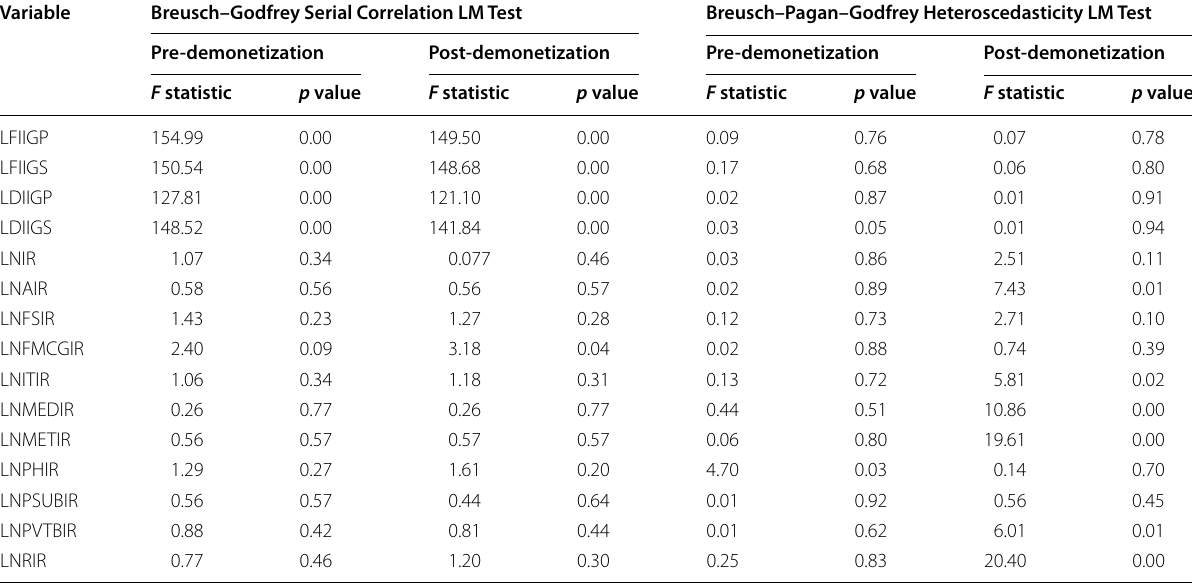
Table 5 Analysis showing testing for serial correlation and heteroscedasticity. Source : Author’s